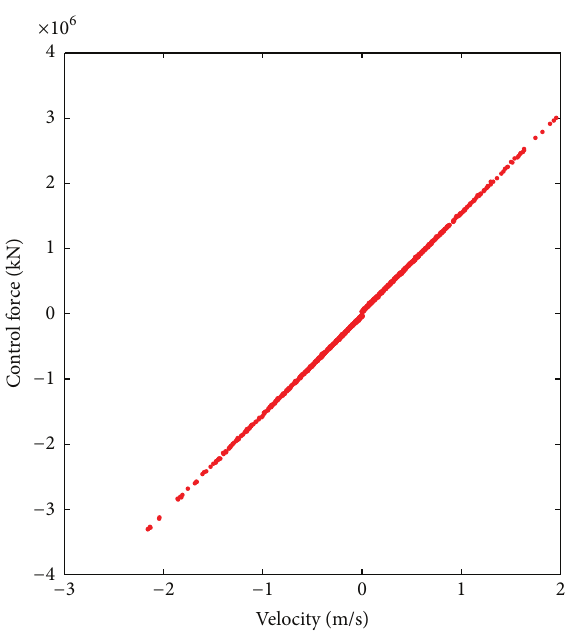
Figure 14: Control force versus